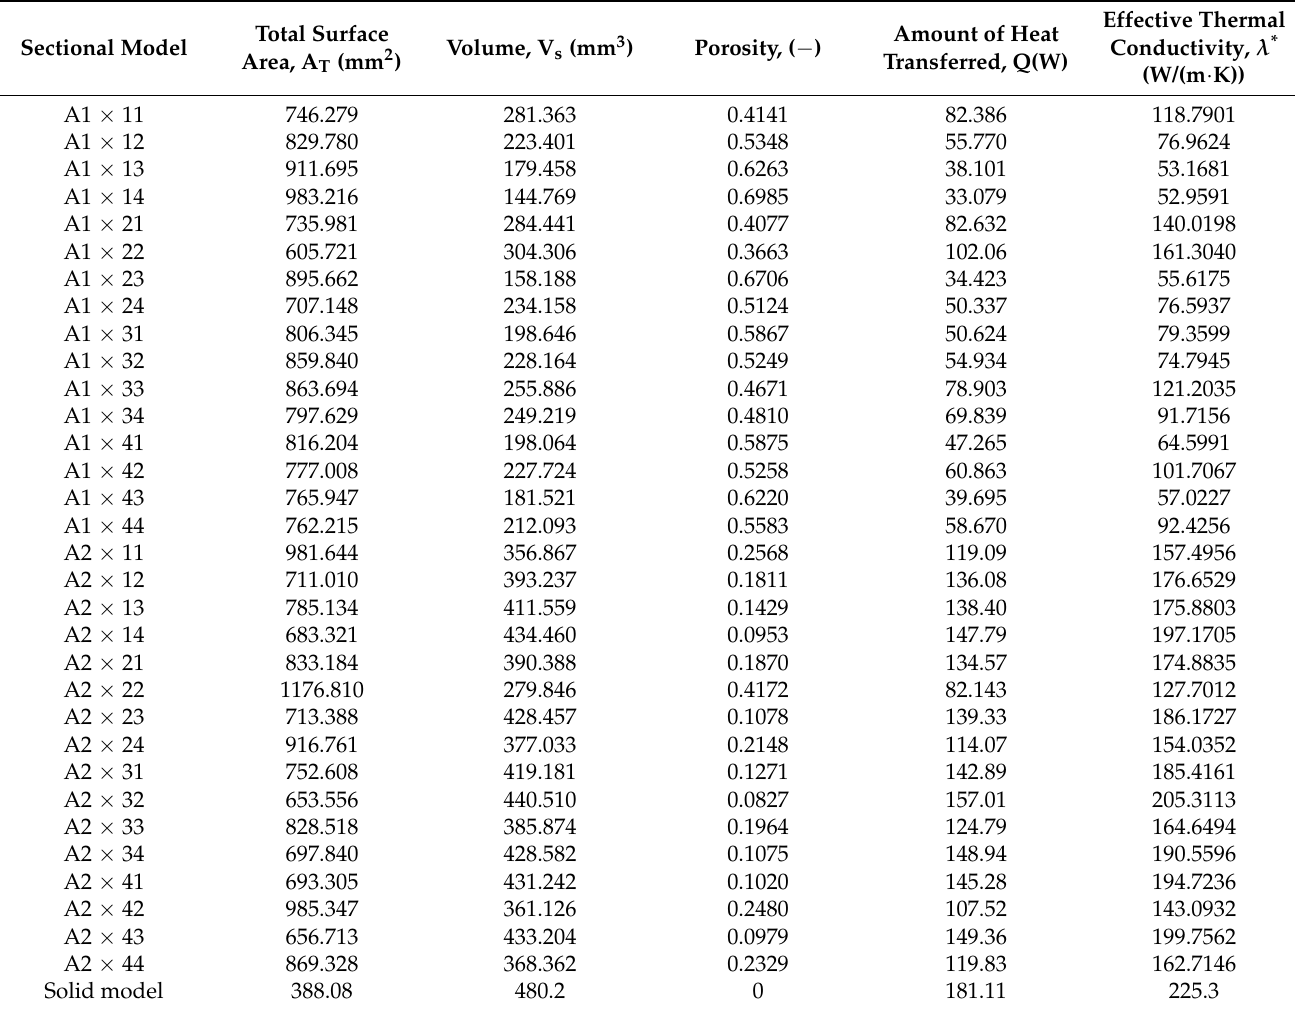
Table 4. Nomenclature, structural parameters, numerical heat transfer and effective thermal conductivity values of the